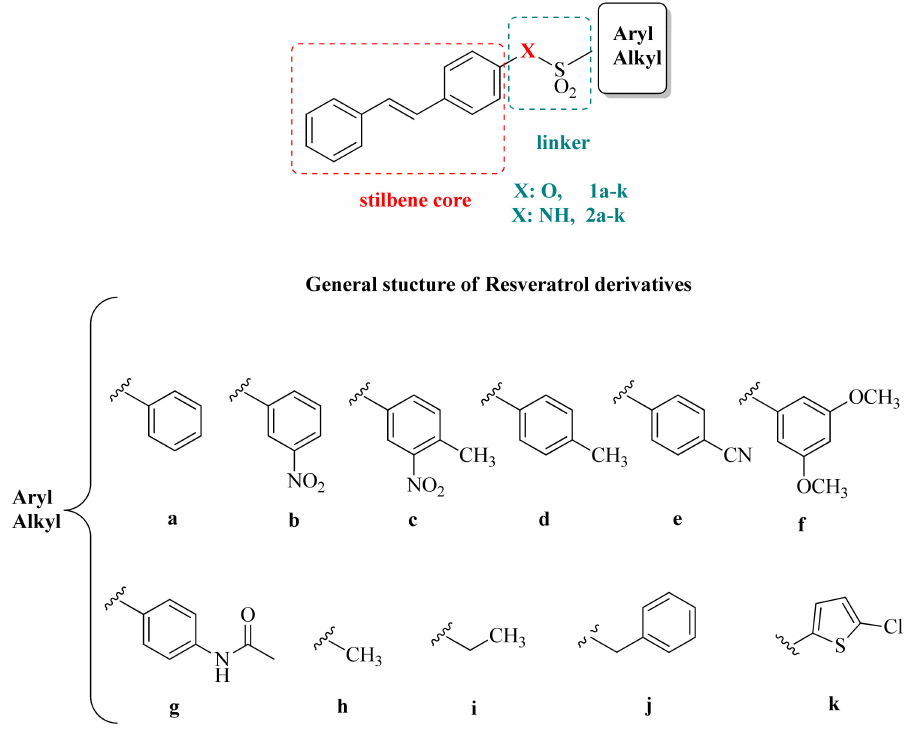
Figure 3. General structure of new sulfonate and sulfonamide derivatives of RSV; X = O, 1a – k ; X = NH, 2a – k . These novel RSV derivatives were screened for in vitro aromatase